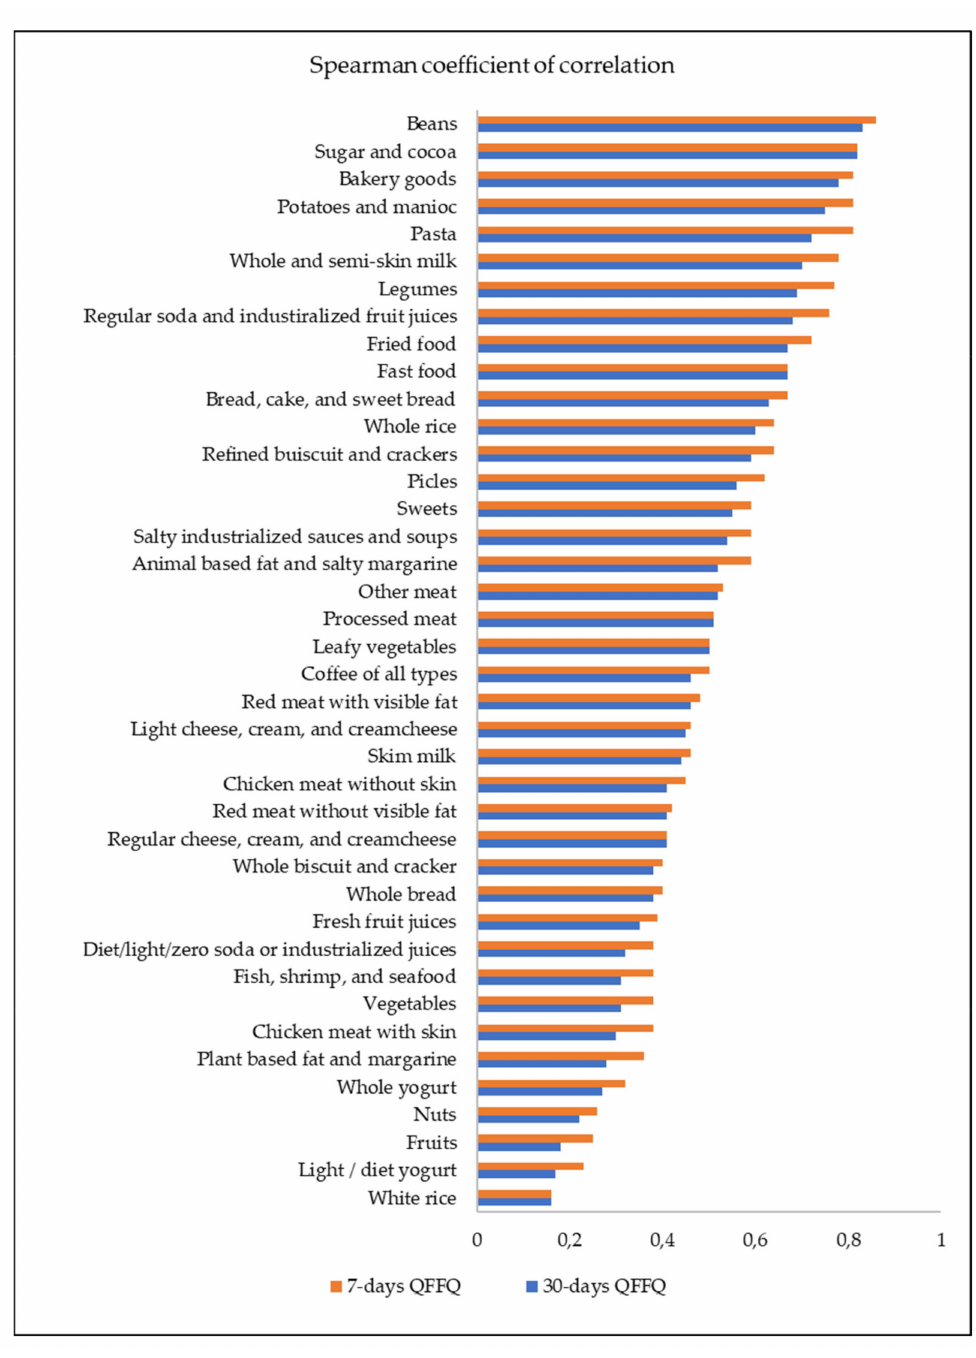
Figure 3. Spearman coefficient of correlation between the first and the second 30-day FG-QFFQ and 7-day FG-QFFQ used to test the reproducibility of measures; p -value <